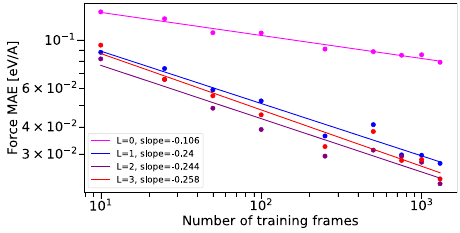
Fig. 4 Lithium Kinetics. Comparison of the Li MSD of AIMD and an example NequIP trajectory of Li 6.75 P 3 S 11 .